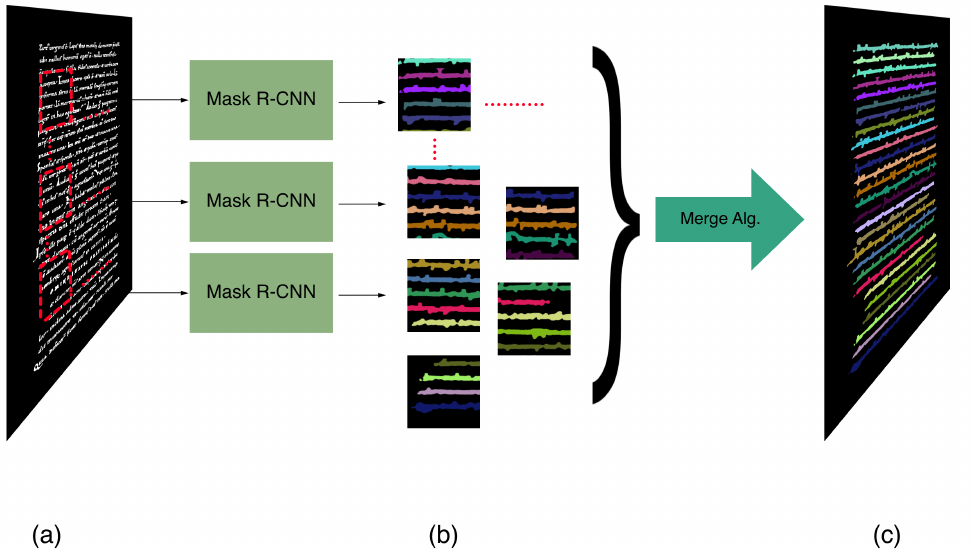
Figure 1. An overview of the proposed method. An overlapping sliding window traverses the input image ( a ) and segments the patches (windows) using the trained Mask R-CNN model. An example of the segmented patches are shown in ( b ). The segmented patches are merged together producing the segmented text lines in a page ( c